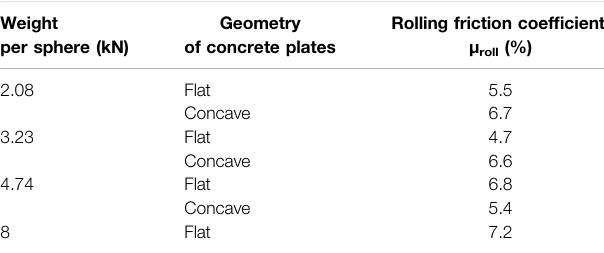
TABLE 3 | Summary ofthe rolling friction coef fi cient μ roll (%) for the varioustested con fi gurations. Weight per sphere